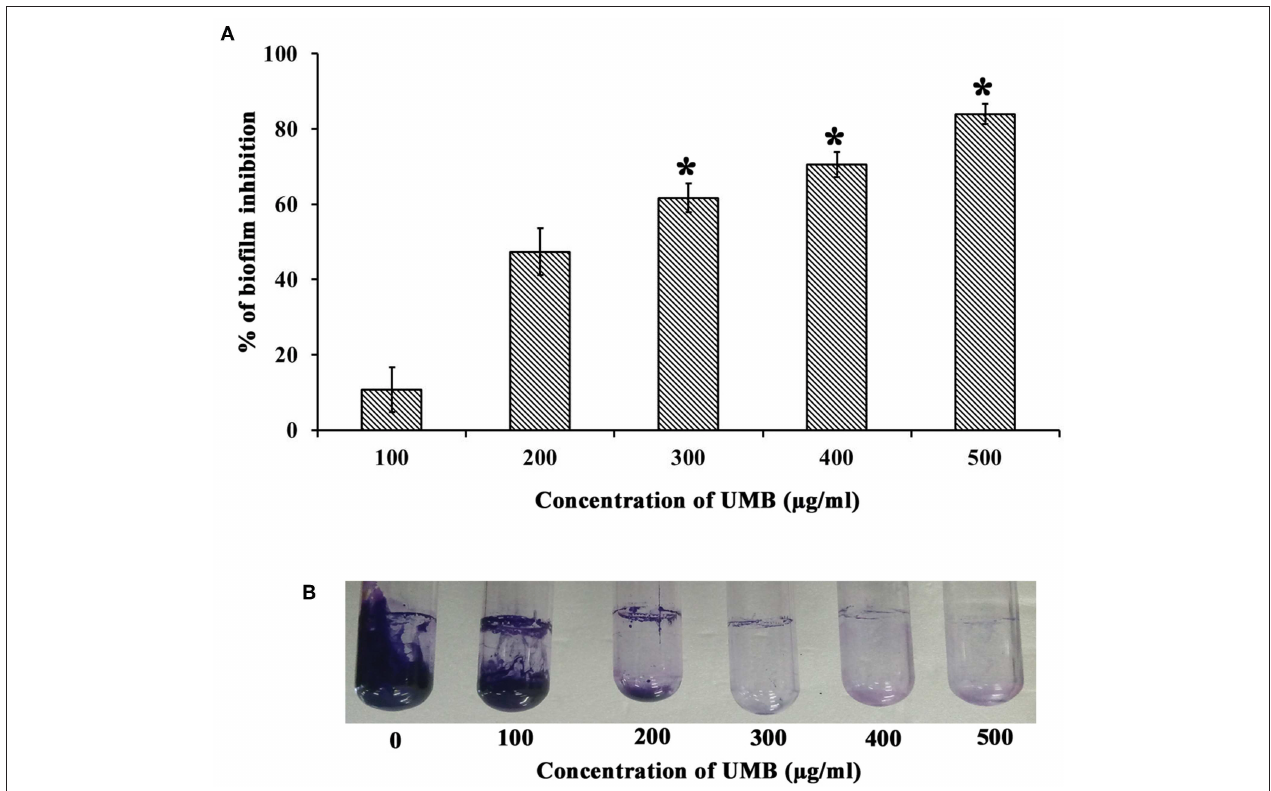
FIGURE 1 | Effect of UMB on biofilm formation of MRSE. (A) Bar graph represents dose dependent inhibition of MRSE biofilm upon treatment with UMB. UMB exhibited a maximum of 83% biofilm inhibition of MRSE at 500 µ g/ml concentration, which was fixed as MBIC. (B) Representative images of glass tubes showcasing the CV stained ring biofilm of MRSE formed in the absence and presence of UMB at varying concentrations. Error bars represent standard deviations. * Statistical significance between control and treated samples from three independent experiments ( p < 0.005).